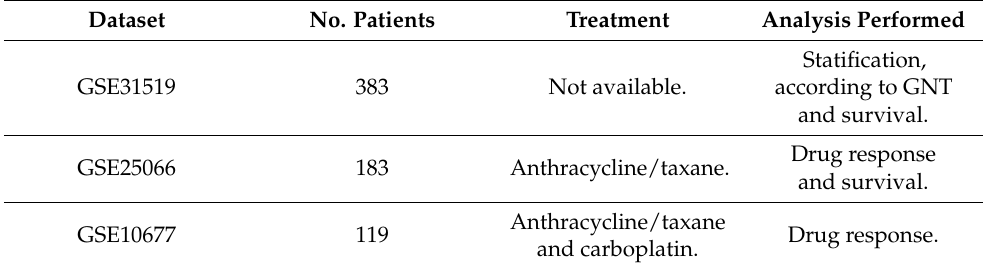
Table 1. Summary of the gene expression data analyzed in the present paper.